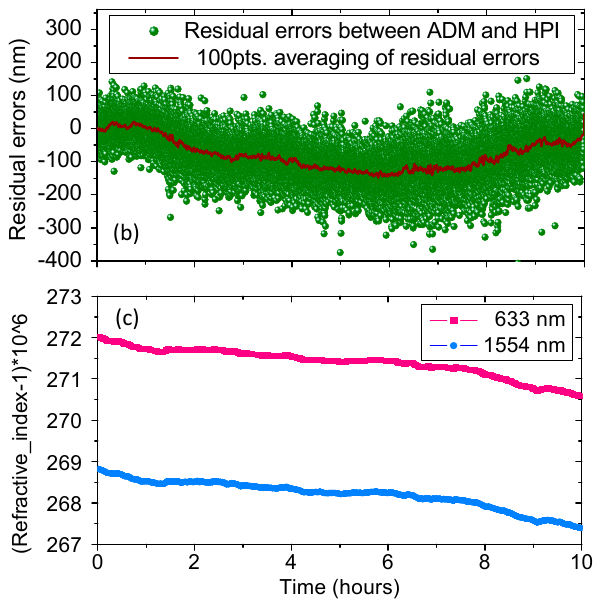
Figure 7. 10 h monitored results. ( a ) Time-traces of measured distances by ADM and HPI. ( b ) Distance residues between ADM and HPI readings. ( c ) Air refractive index for ADM and HPI.